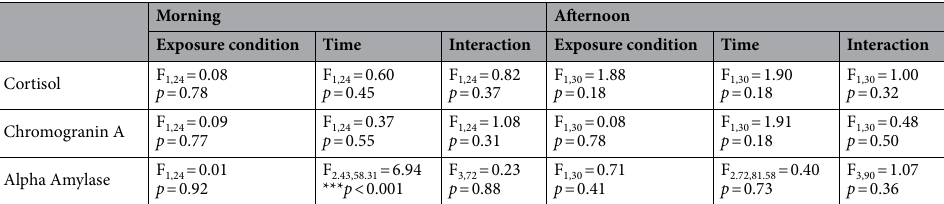
Table 1. Statistical analysis results (F-values and p values) of biochemistry assays for salivary biomarkers of stress. Saliva concentration of cortisol, chromogranin A and alpha amylase were analyzed by two-way repeated-measure ANOVA, considering as factors the exposure condition and the collection time in the morning or in the afternoon. For cortisol we considered time factor (two levels: Sal 1, Sal 4) and exposure condition factor (two levels: real exposure, sham exposure); for chromogranin A: time factor (two levels: Sal 2, Sal 3) and exposure condition factor (two levels: real exposure, sham exposure); for alpha amylase: time factor (four levels: Sal 1, Sal 2, Sal 3, Sal 4) and exposure condition factor (two levels: real exposure, sham exposure). Only alpha amylase collected in the morning showed a statistically significant variation, due to time factor (*** p <